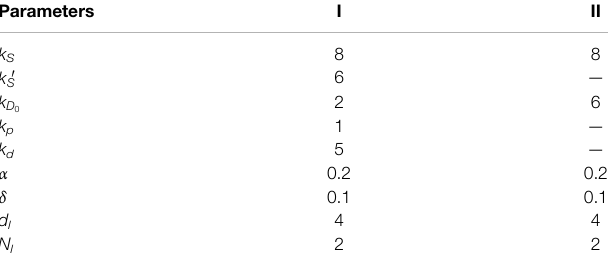
TABLE 1 | Parameter settings in validation condition I and II.